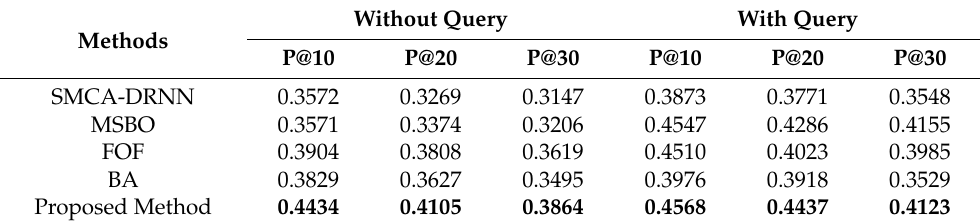
Table 3. Comparative analysis of methods with and without query